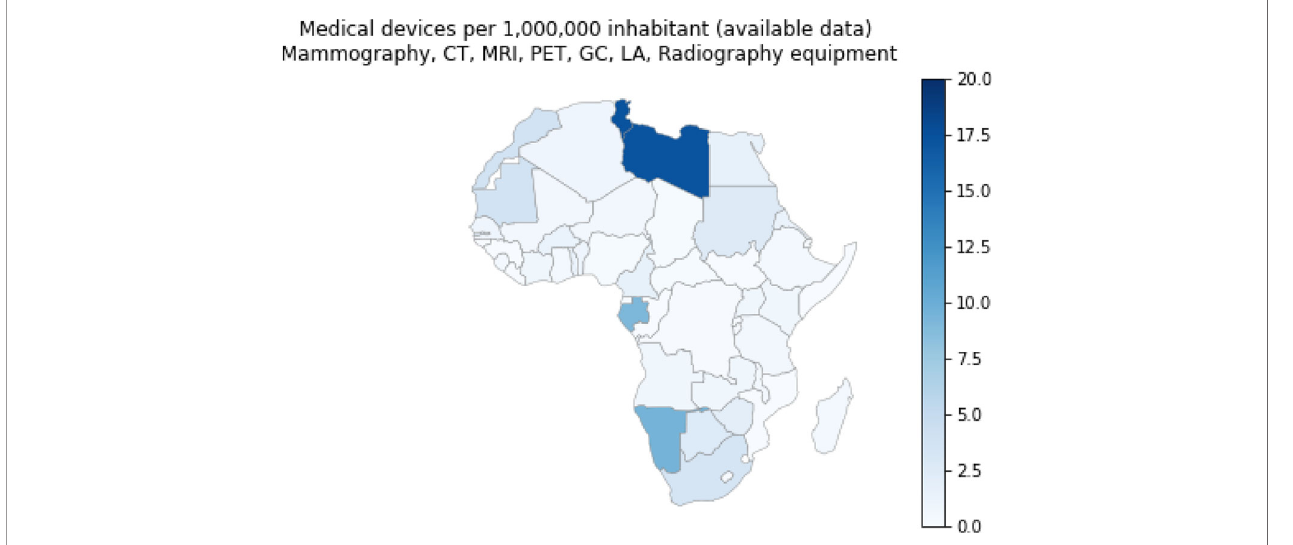
FIGURE 11 | Cancer Medical devices per 1,000,000 inhabitants. These include the following medical devices: Mammographs, Computed Tomography, Magnetic Resonance Imaging, Positron Emission Tomography, Gamma Camera or Nuclear Medicine, Linear accelerator, Telecobalt unit, Radiotherapy. Source Global atlas of medical devices, World Health Organization, 2017.